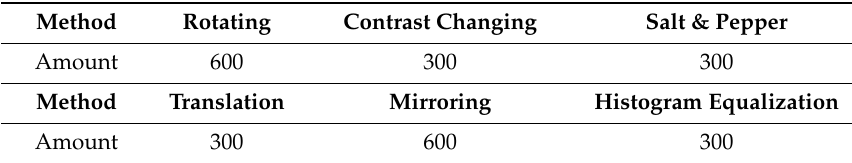
Table 1. Data augmentation.